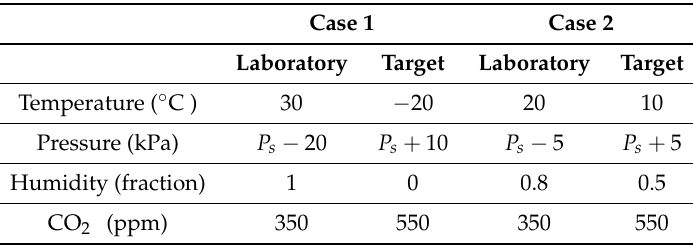
Table 2. Linear variation of atmospheric parameters x